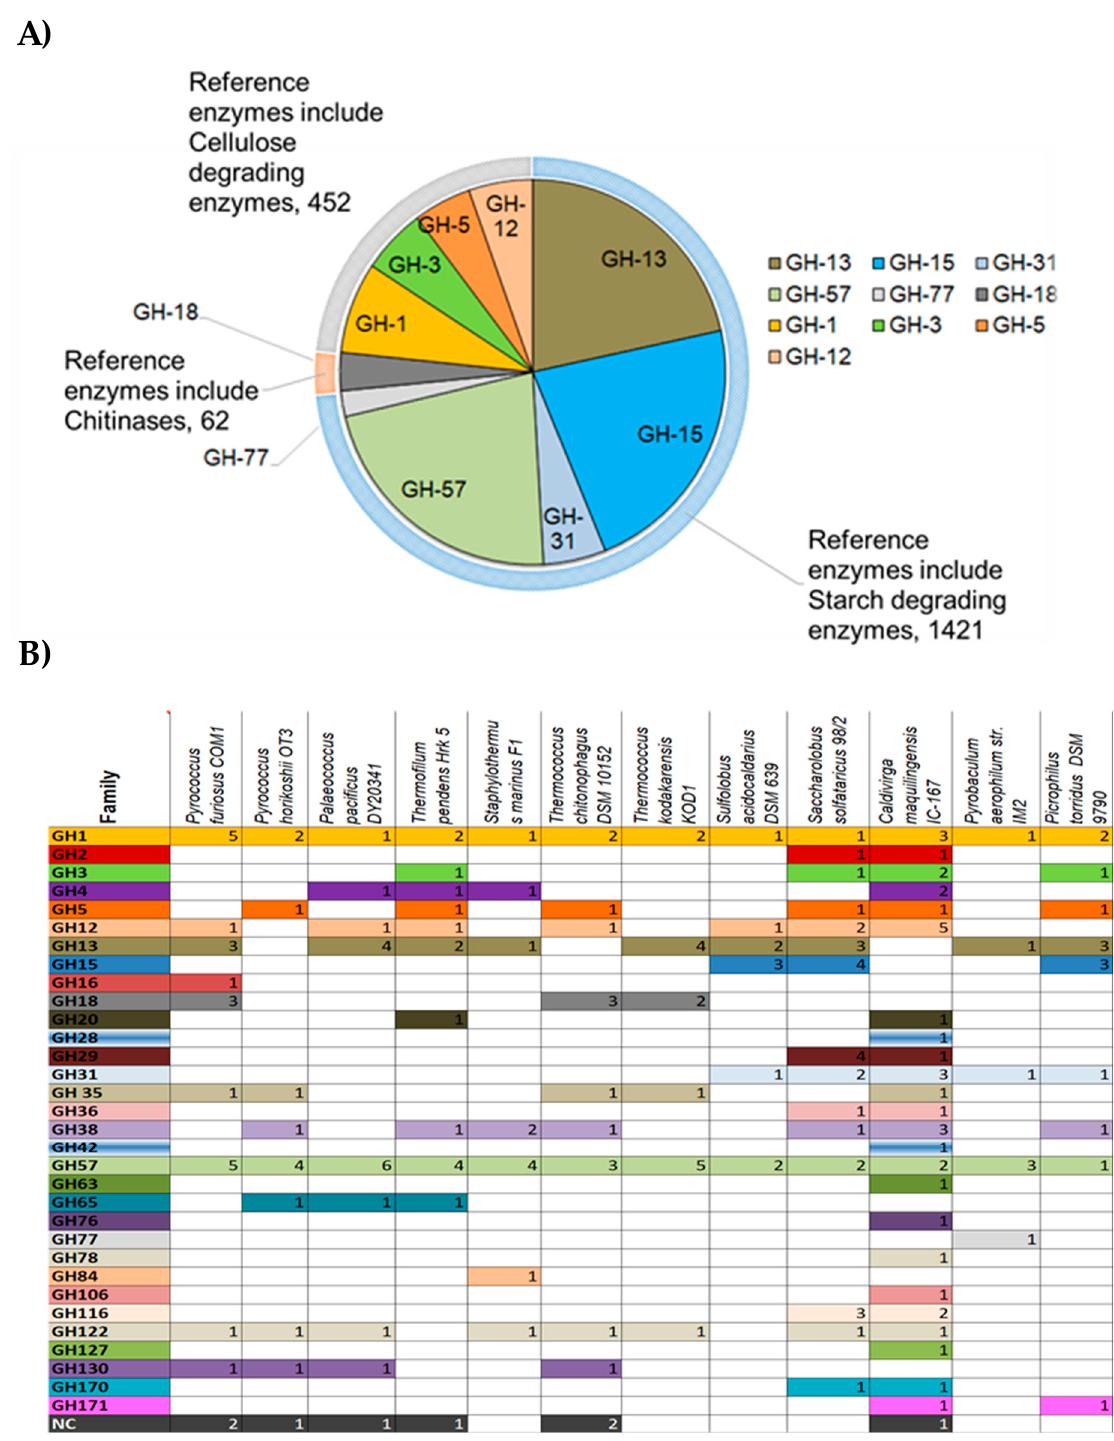
Figure 2. Classification of most abundant archaeal GHs [20]. ( A ) Diagram showing abundancy of GHs in Archaea and their repartition into different enzyme classes. Sequences from archaeal genomes corresponding to each GH family were retrieved from the CAZY database and the number of occurring sequences for each GH family was determined and represented on the pie chart; ( B ) Occurrence of GHs families in representative hyperthermophilic Archaea. NC: Non-classified.